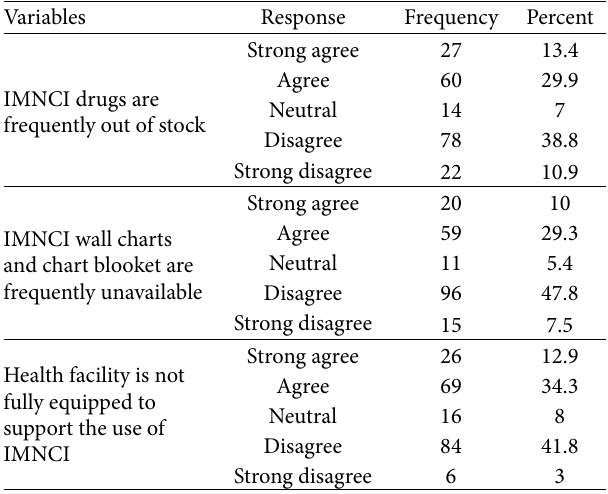
Table 14: Availability of resources to the IMNCI strategy.